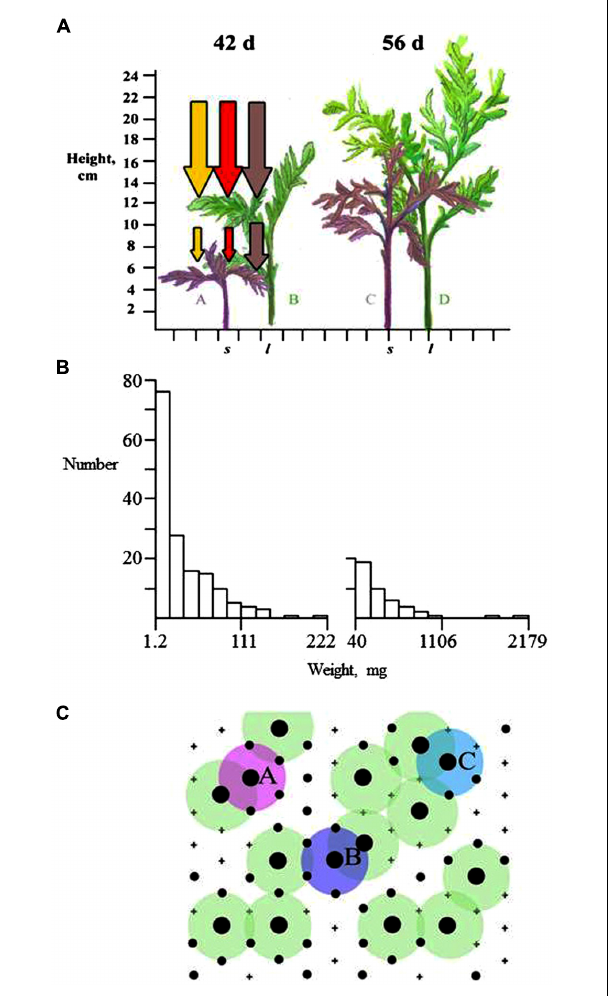
FIGURE 1 | Development of population and stand structure in T. patula planted in a 2 cm triangular lattice (afterTurley and Ford, 2011). (A) Plant height after 42 and 56 days showing large (C, D) and small (A, C) plants aligned on a 2 cm scale with diagrammatic reductions in PAR, and red and far-red light. New foliage grows upwards and away from the stem so that competitive interaction takes place in three dimensions. (B) Frequency histograms of plant dry weight at 42 and 56 days illustrating reduction in total number from 400 plants and right-skewed distributions. (C) The spatial arrangement of large and small plants, represented by black circles of their respective sizes at the lattice points and dead plants indicated by + . Plants A , B , and C are each one of a pair of large plants that are within 2 cm of each other, whereas other large plants are further than 2 cm from a large